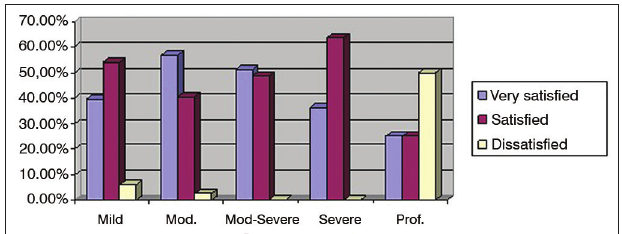
Figure 4. Percent distribution of hearing loss degrees per level of global satisfaction. Mod.: Moderate; Mod-Severe: Moderate-severe;